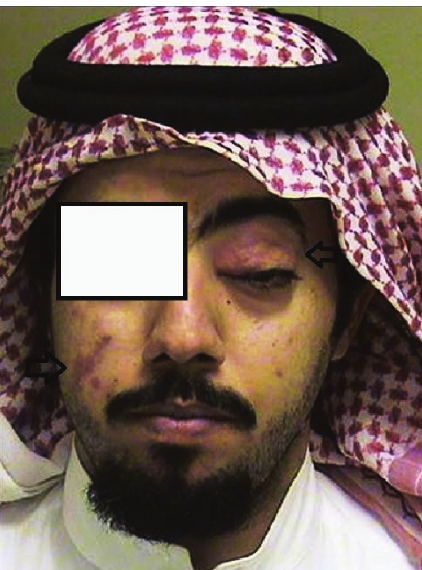
Figure 1: Physical examination showing right cheek erythematous lesion of size 3 × 3 cm and a similar erythematous mass over left upper medial canthus of size 1 × 2 cm with ptosis.